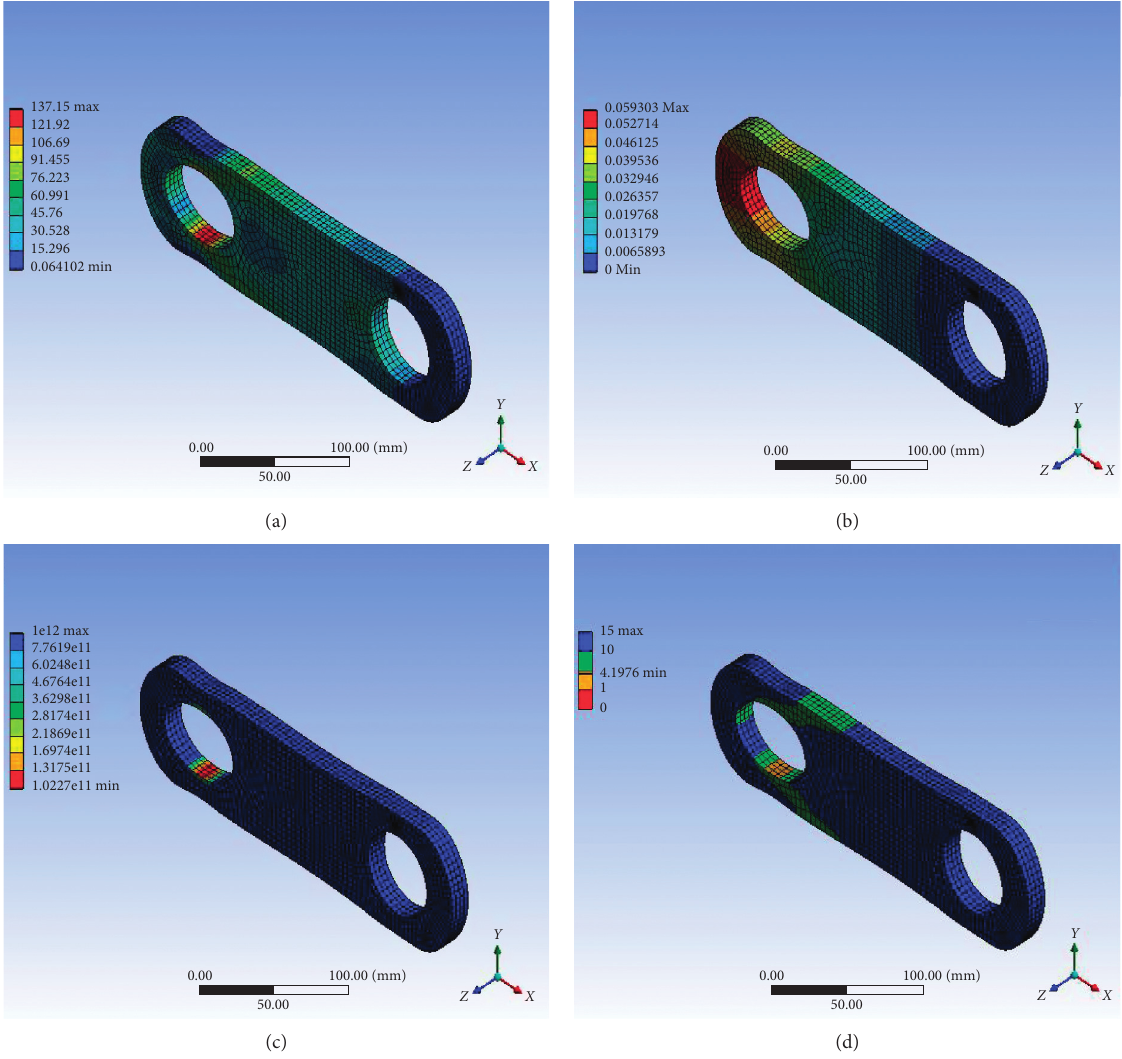
Figure 10: Simulation results for chain link without a modeled crack with neck radius 831.9mm ( X � 3mm): (a) equivalent stress, (b) deformation, (c) fatigue life, and (d) safety